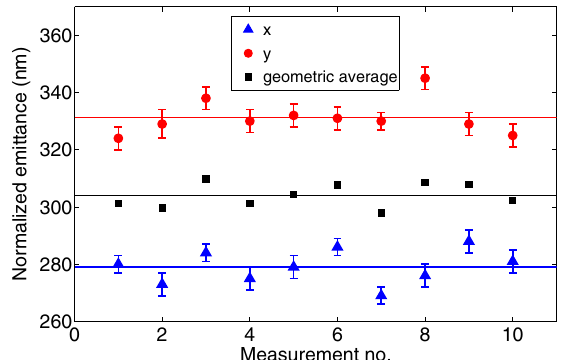
FIG. 61. Normalized horizontal (blue) and vertical (red) pro- jected emittance obtained for a bunch charge of 200 pC from ten consecutive measurements with the CTF gun, illustrating the stability of machine and diagnostics chain. The geometric mean of the horizontal and vertical results is shown in black. The continuous horizontal lines represent the averages over the ten